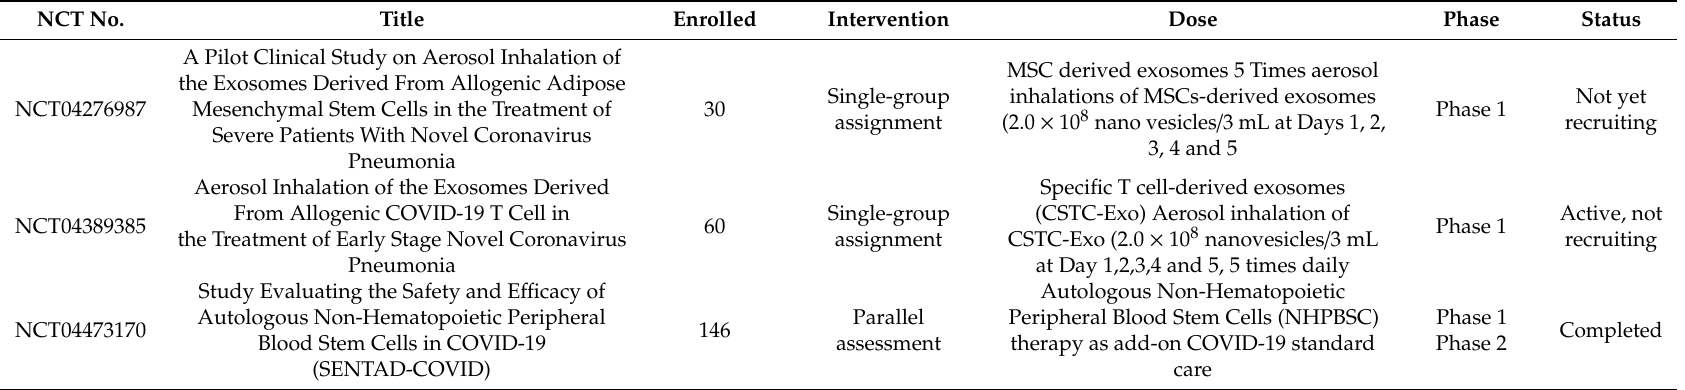
Table 2. Clinical trials using inhalation as the delivery method for COVID-19 as an exemplar respiratory disease. NCT